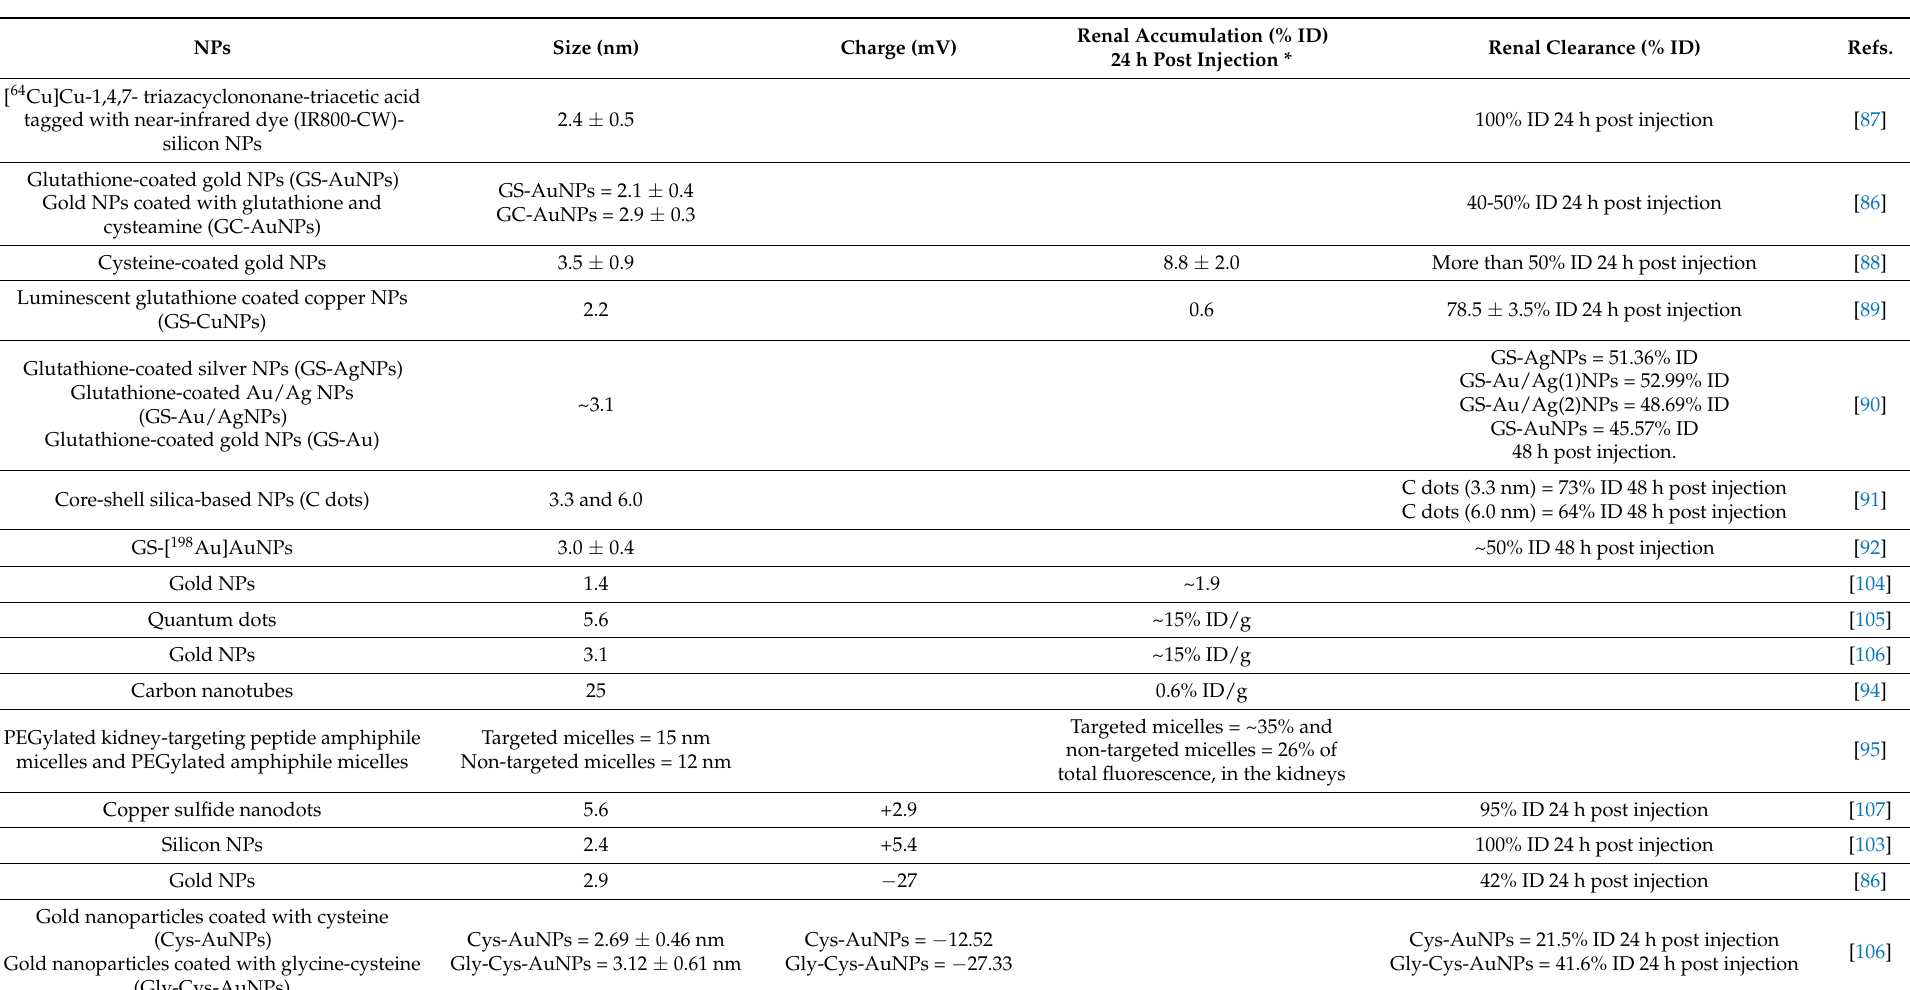
Table 2. The influence of the physicochemical properties (size and charge) of various NPs on their renal clearance and